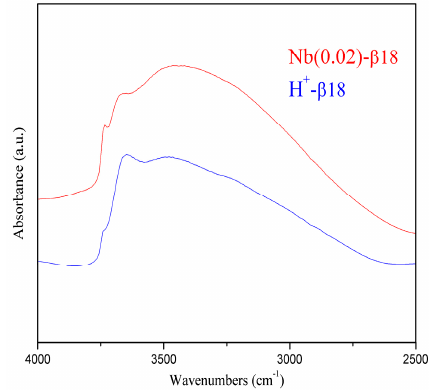
Figure 4. FTIR spectra of H- β 18 and Nb(0.02)- β 18.